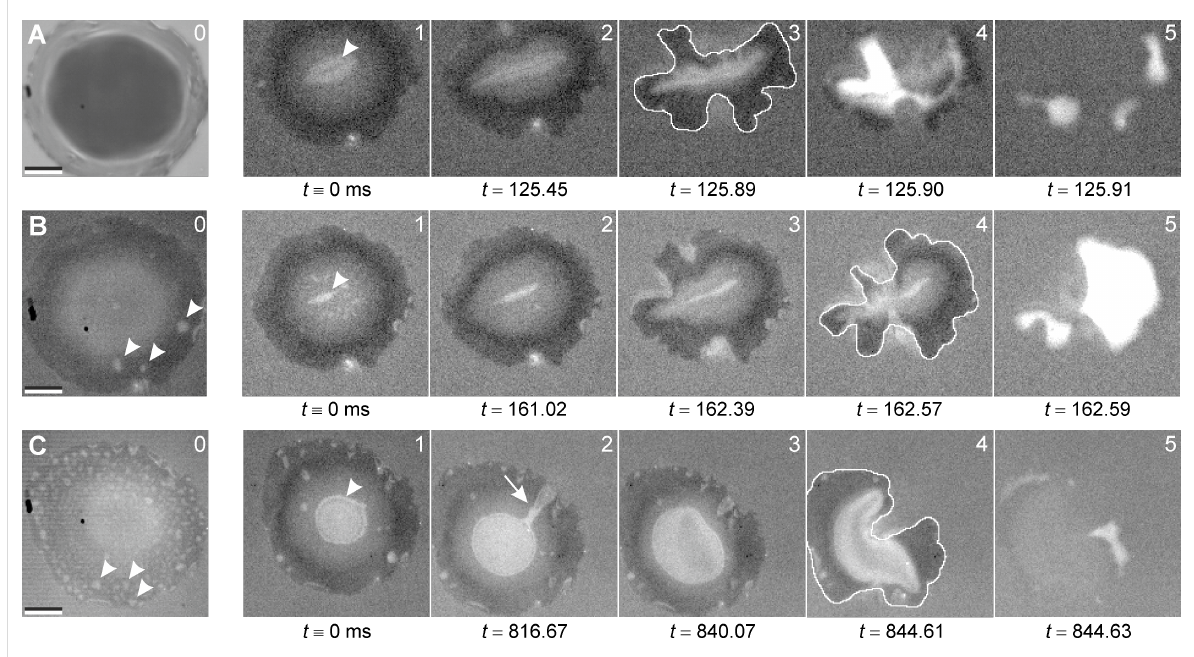
Figure 5: Detachment sequences of individual MSAMSs separating from a glass substrate for the sample 1 in the dry–wet state (A), second measurement of the sample 1 in the wet state (B), and the sample 2 in the wet state (C). Images labelled with '0' correspond to equilibrium conditions right after contact formation. Note, in (A) contact formation was under ambient conditions. Images with index '1' to '5' are still images of the actual detachment sequence. Frames set to t ≡ 0 ms (images with index '1') were arbitrarily chosen as a reference. All times are given in milliseconds (ms). During detachment water inclusions were present within the contact interface of MSAMS and glass (white arrowheads). In sequences (A) and (B) microcavitation was observed indicated by the white region in images A4–5 and B5. The white arrow (C2) indicates channel formation by interfacial crack propagation between the confined water within the contact interface and the surrounding water. The white traces in A3, B4, and C4 outline the contact area prior to detachment. For comparison, detachment sequences in the dry state are shown [4,9,11,17]. Scale bar, 10